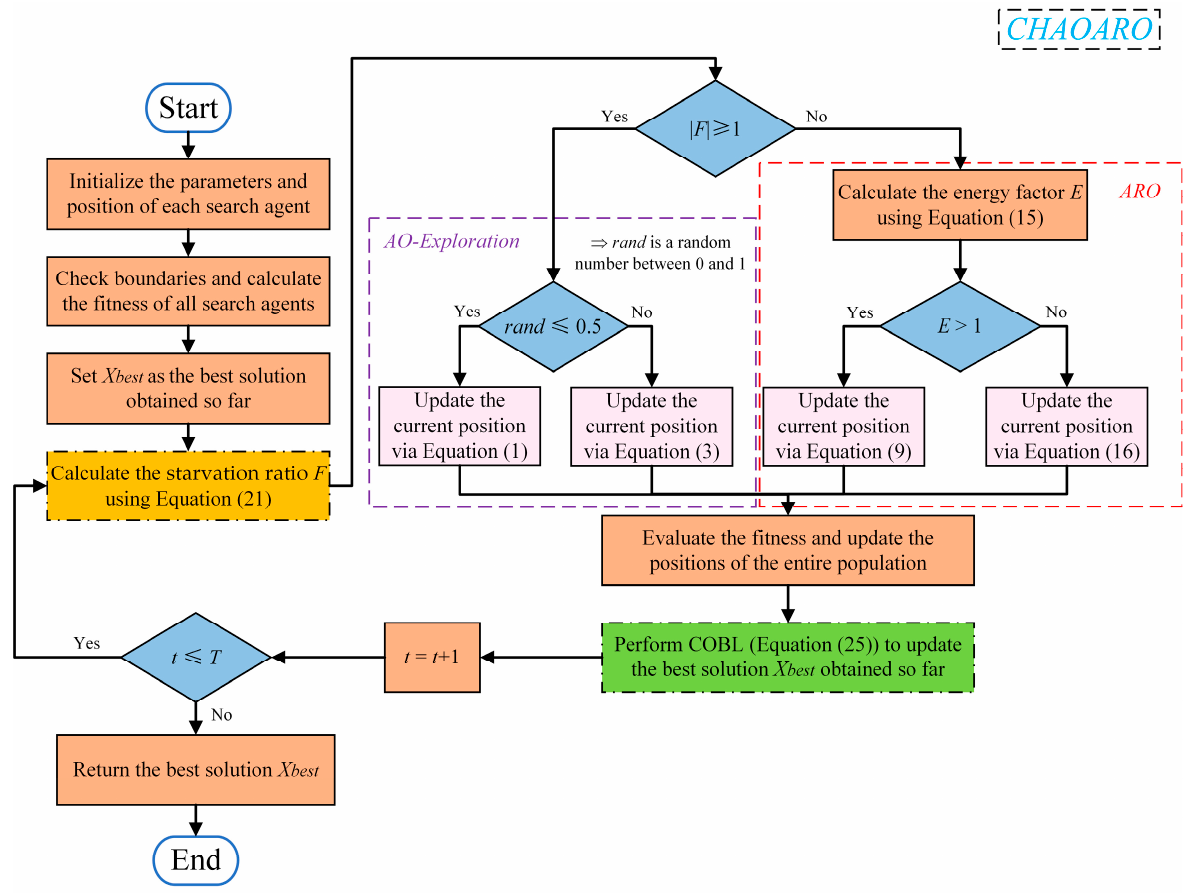
Figure 6. Flow chart of the proposed CHAOARO. Algorithm 1 Pseudo-code of the proposed CHAOARO